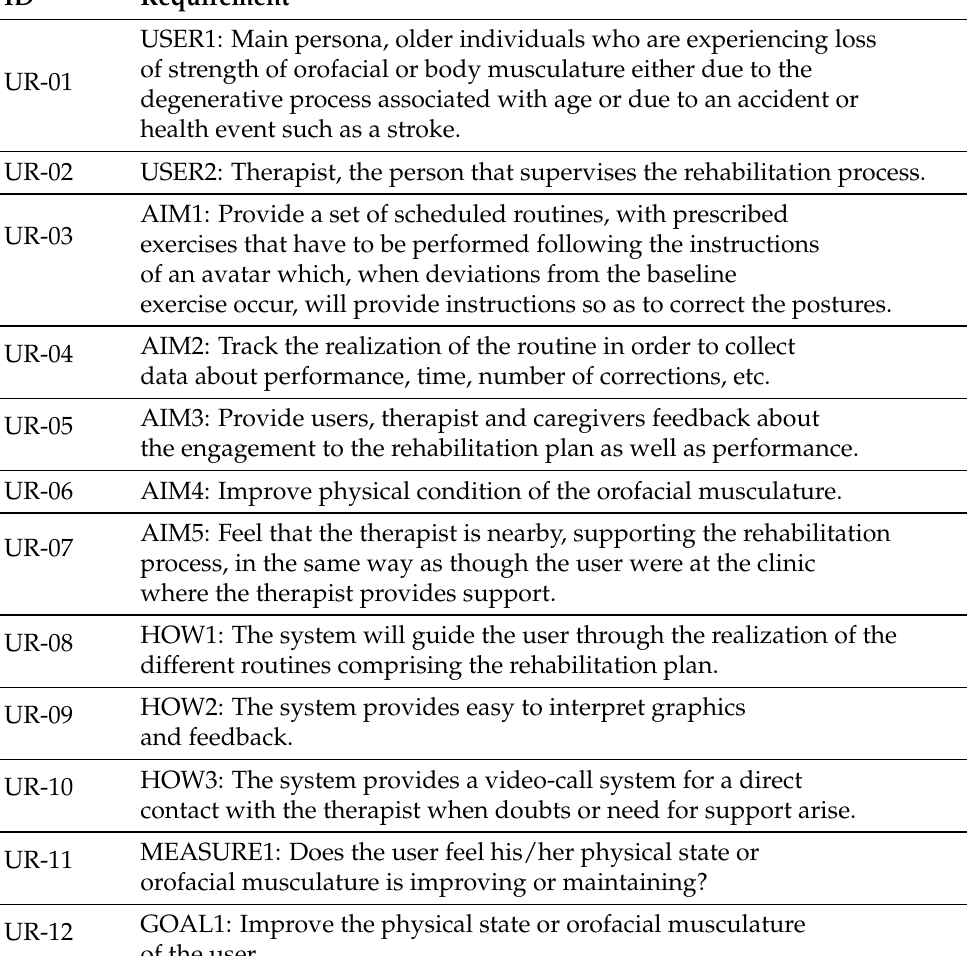
Table 6. User Requirements for orofacial and physical